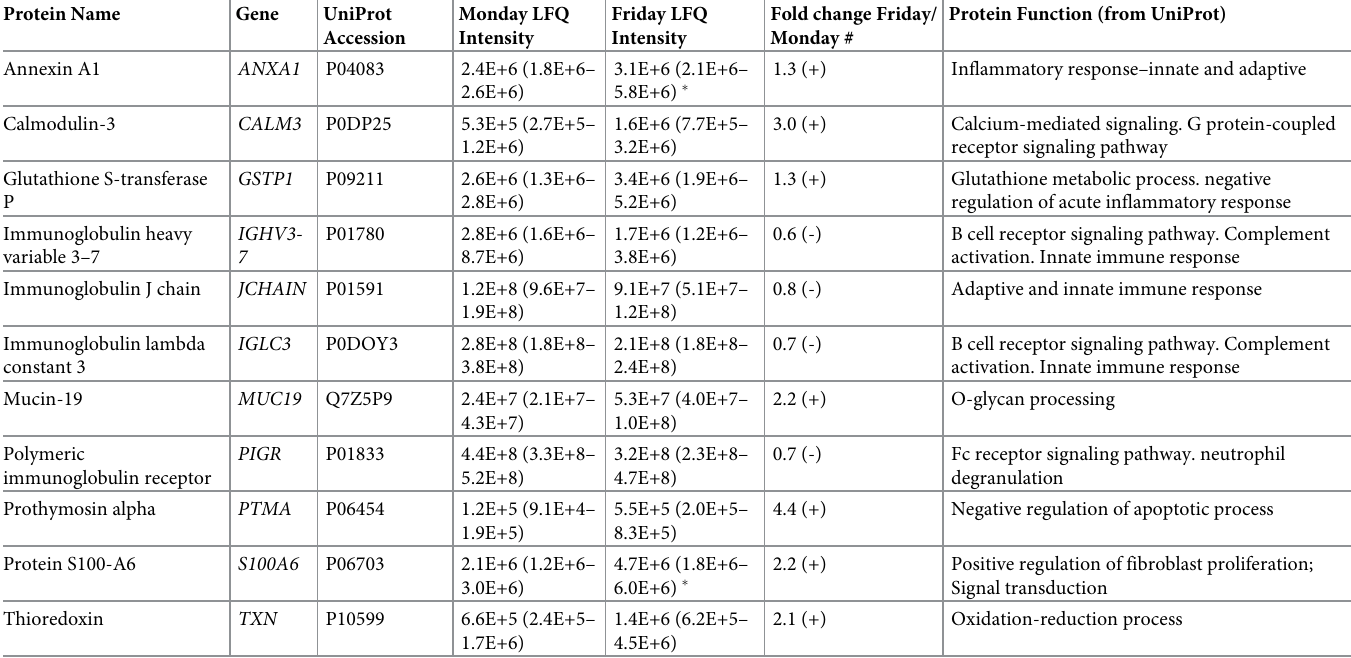
Table 3. Proteins obtained from orthogonal partial least squares-discriminant analysis when comparing welders Monday vs Friday year1. Protein